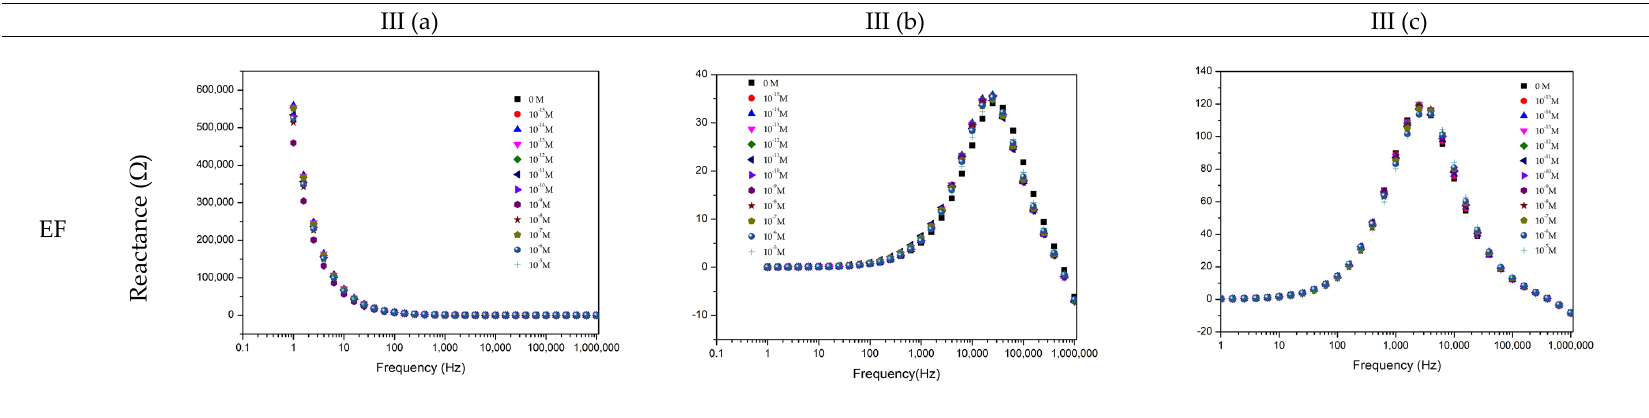
Figure 2. Reactance (imaginary) impedance spectra of the sensor device ( a ) of the gold IDE sensor, ( b ) of the (PAH/GO) 5 sensor, and ( c ) of the (PEI/PSS) 5 sensor, immersed in TCS DW ( I ), MW ( II ), and EF ( III ) at different TCS concentrations.